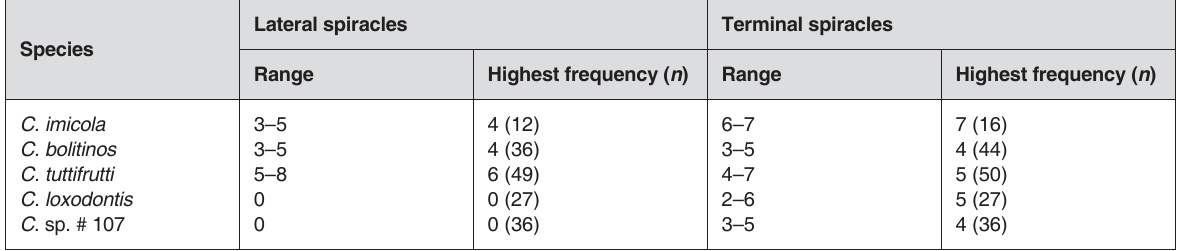
TABLE 2 The number and greatest frequency of lateral and terminal spiracles on the respiratory organs of the pupae of five species of Culicoides of the Imicola complex